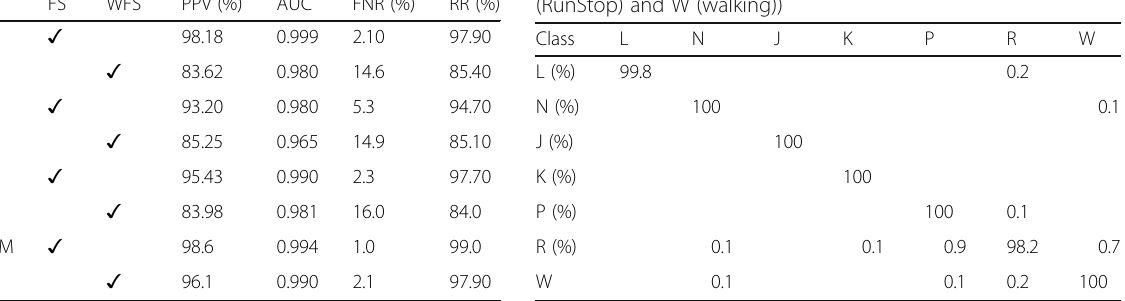
Table 11 Recognition results on UIUC dataset Method